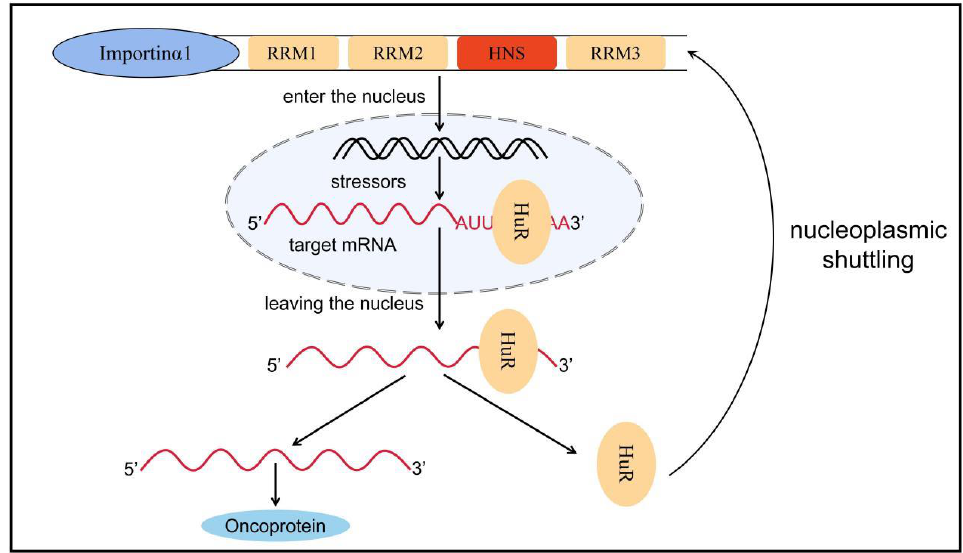
Figure 2. Nucleoplasmic transport of HuR. HuR is mainly distributed in the nucleus, but when stimulated by factors such as microenvironmental changes, HuR can bind to target mRNA to form a HuR-mRNA complex, which protects the target mRNA from degradation by nucleic acid exonucleases and transfers it from the nucleus to the cytoplasm via HNS. Subsequently, HuR dissociates from the target mRNA and rapidly returns to the nucleus with the assistance of transporter proteins such as importin α1 . Nucleoplasmic translocation of HuR increases the stability of the target mRNA, promotes mRNA translation, and causes a variety of inflammatory phenotypes, ultimately promoting tumor formation and progression. RRM: RNA recognition motif, HuR: human antigen R, HNS: HuR nucleoplasmic shuttling sequence.